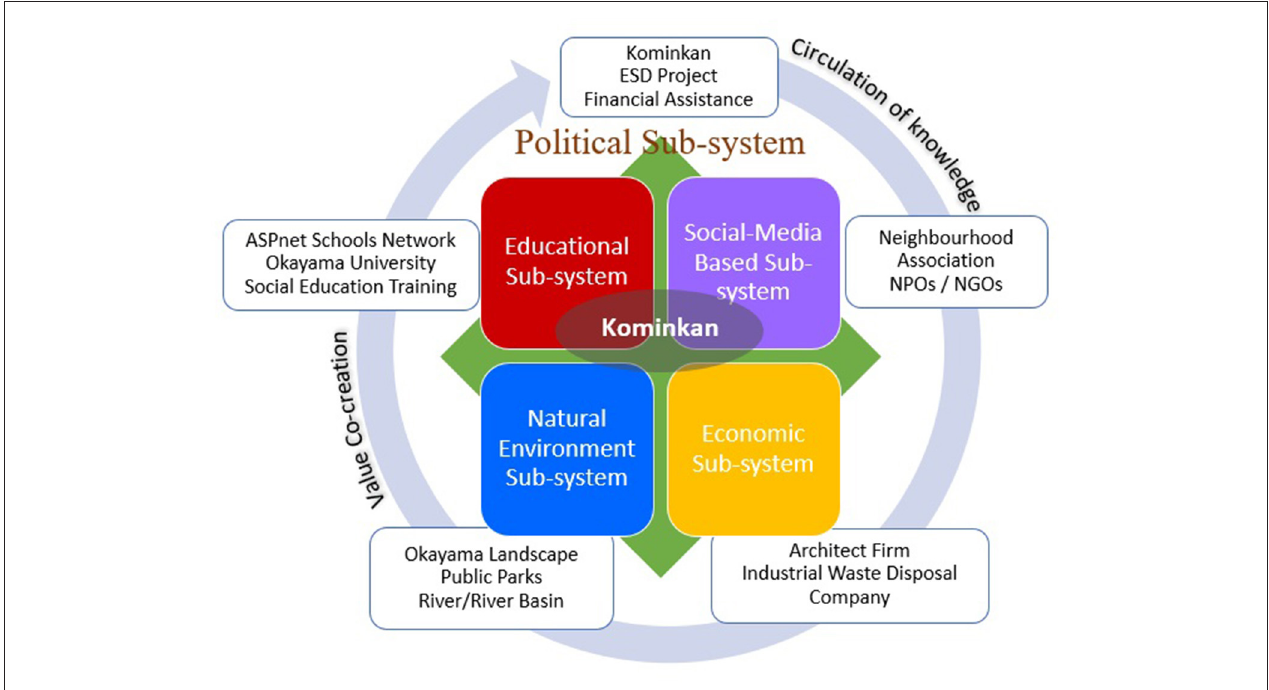
FIGURE 6 | Quintuple helix model version of the Okayama model of